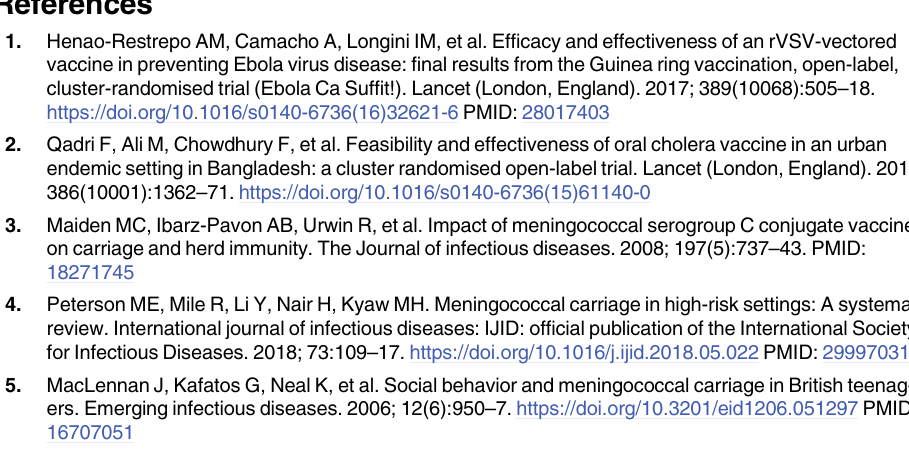
S1 Table. List and definition of risk factor variables